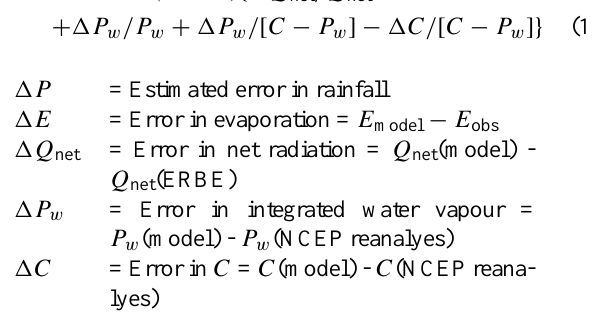
5 Interaction between different